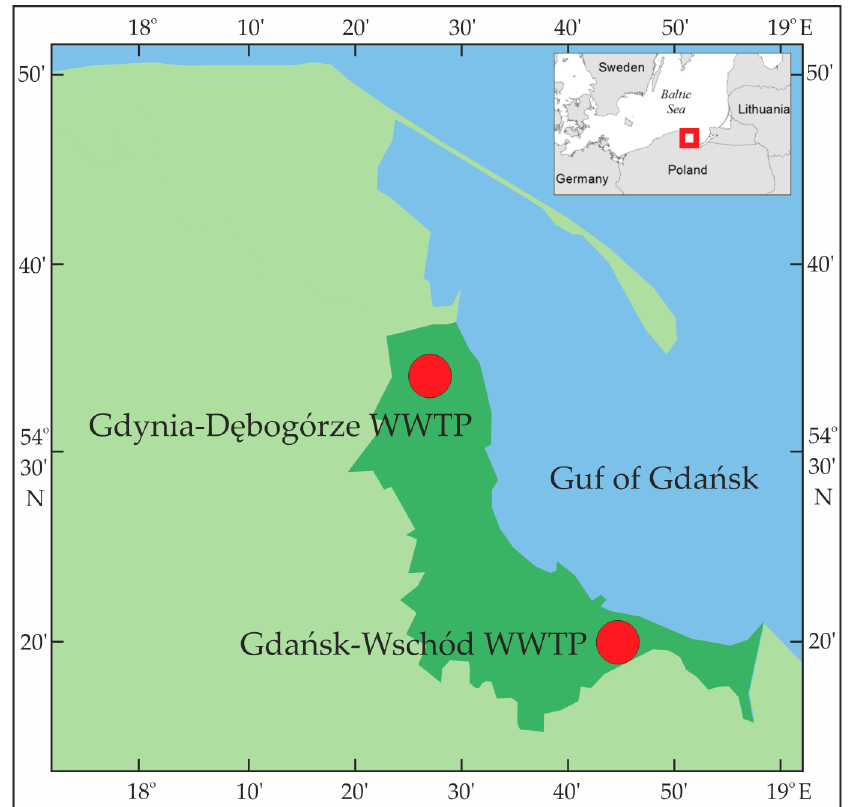
Figure 1. Map with marked wastewater treatment plants on which the research was conducted.